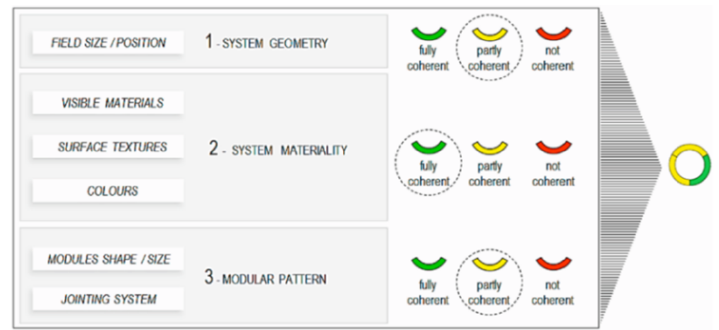
Figure 2. Levels of integration quality of the solar system. Reproduced with permission from Maria Cristina Munari Probst, Christian Roecker, Solar Energy; published by Elsevier, 2019 [15,24].